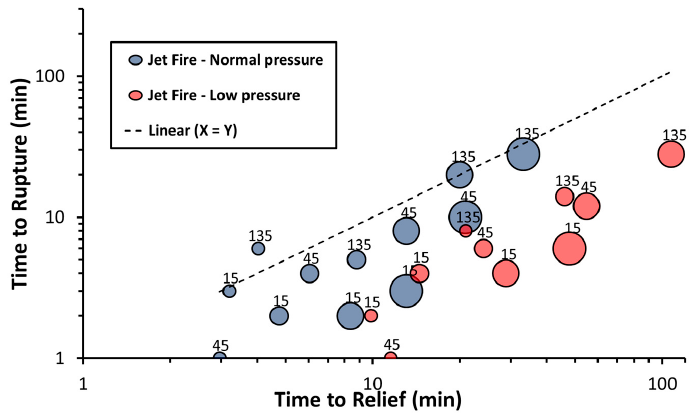
Figure 7. Grouped results for the jet fire scenario in terms of vessel diameter, design pressure and operating pressure.